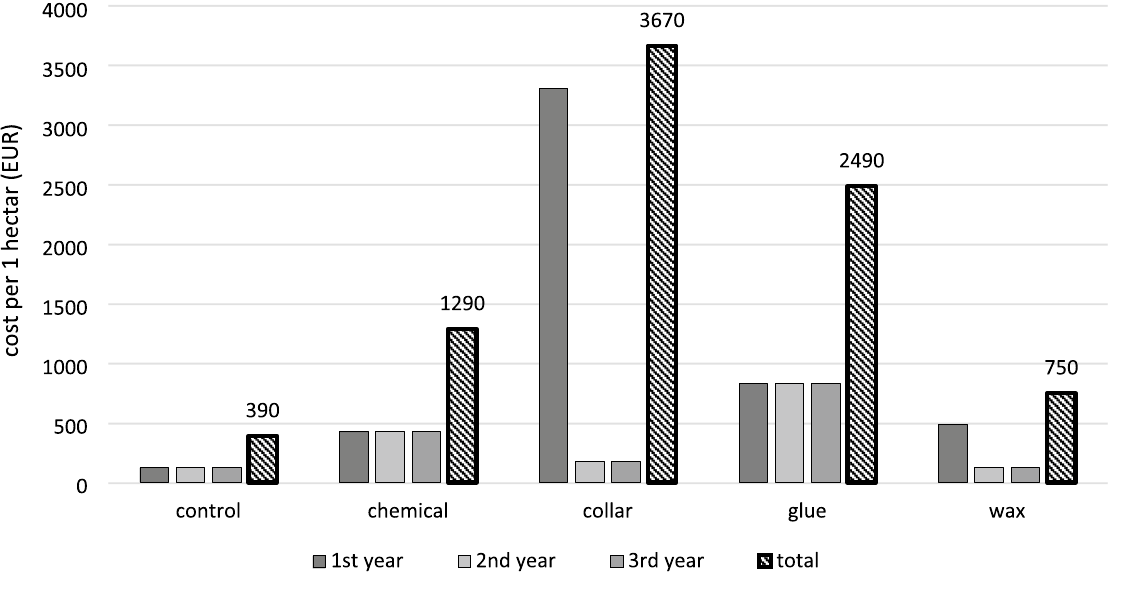
Figure 6. Costs per ha to protect spruce seedlings with the treatments. Treatment costs per ha are for the standard number of 3000 seedlings/ha. All columns include standard costs for weeding once each year (130 EUR/ha). Price for 1 l of Vaztak Active is approximately 32 EUR (required amount = 0.6 l/ha). Discount price for 1 bottle of Vermifix spray is approximately 2.3 EUR (required amount = 45 bootles/ha). Price for 1 collar is approximately 1 EUR (required amount = 3000 collars/ha). Costs per 1 waxed seedling are 0.12 EUR (material and service). The presented prices are valid for Slovakia (year